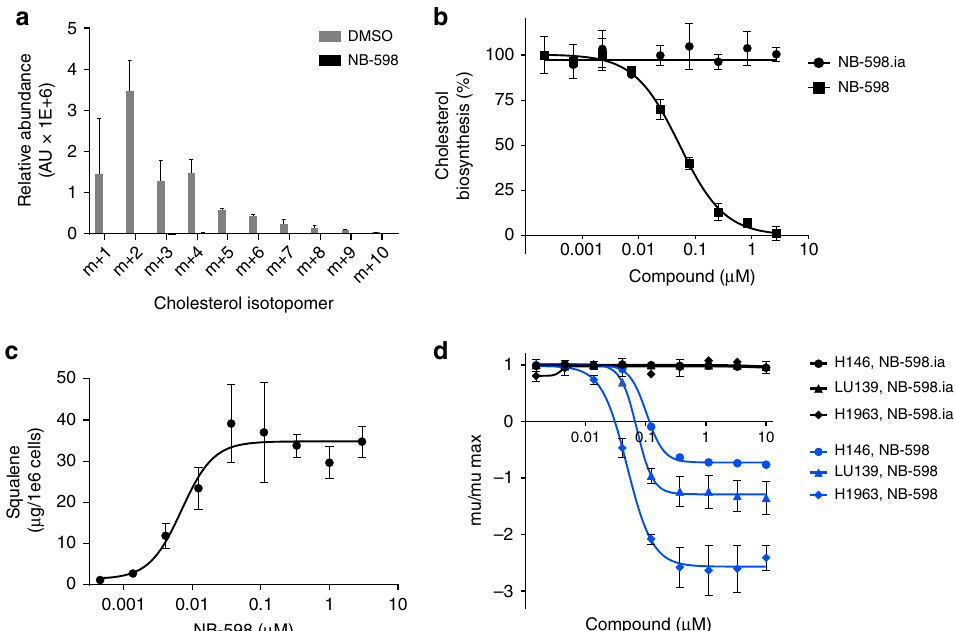
Fig. 2 NB-598 is a speci fi c SQLE inhibitor. a Cholesterol isotopomer distribution in a 13 C 2 -acetate labeling experiment. H1963 cells were co-treated with 1 μ M NB-598 and 500 μ M 13 C 2 -acetate for 48 h. b De novo cholesterol biosynthesis inhibition measured in H1963 cells using on cholesterol m + 2 isotopomer were quantitated to generate the dose – response curves. c Squalene accumulation measured in LU139 cells after 24 h of NB-598 treatment. d NB-598 and NB-598.ia sensitivity in a representative panel of SQLE-sensitive cell lines. For all panels, mean values of triplicate measurements from a representative experiment are plotted and error bars represent